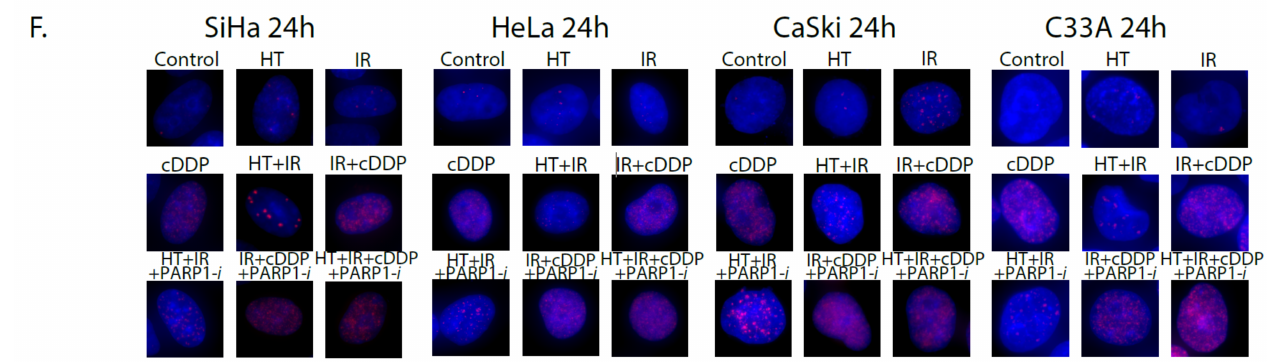
Figure 2. In vitro analysis of γ -H2AX foci per nucleus in cervical cancer cell lines SiHa, HeLa, CaSki, and C33A. ( A , B ) Dis- playing the effects 30 min after treatment with ionizing radiation (IR), cisplatin (cDDP), hyperthermia (HT) and PARP1- inhibition (PARP1- i ) in different combinations. ( C ) Appearance of γ -H2AX foci in representative cervical cancer cell nuclei per treatment at 30 min after treatment. ( D , E ) Displaying the effects 24 h after treatment with ionizing radiation (IR), cisplatin (cDDP), hyperthermia (HT) and PARP1-inhibition (PARP1- i ) in different combinations. ( F ) Appearance of γ -H2AX foci in representative cervical cancer cell nuclei per treatment at 24 h after treatment. * p < 0.05, ** p < 0.01, *** p < 0.001, **** p < 0.0001 compared with corresponding controls, Mann Whitney U